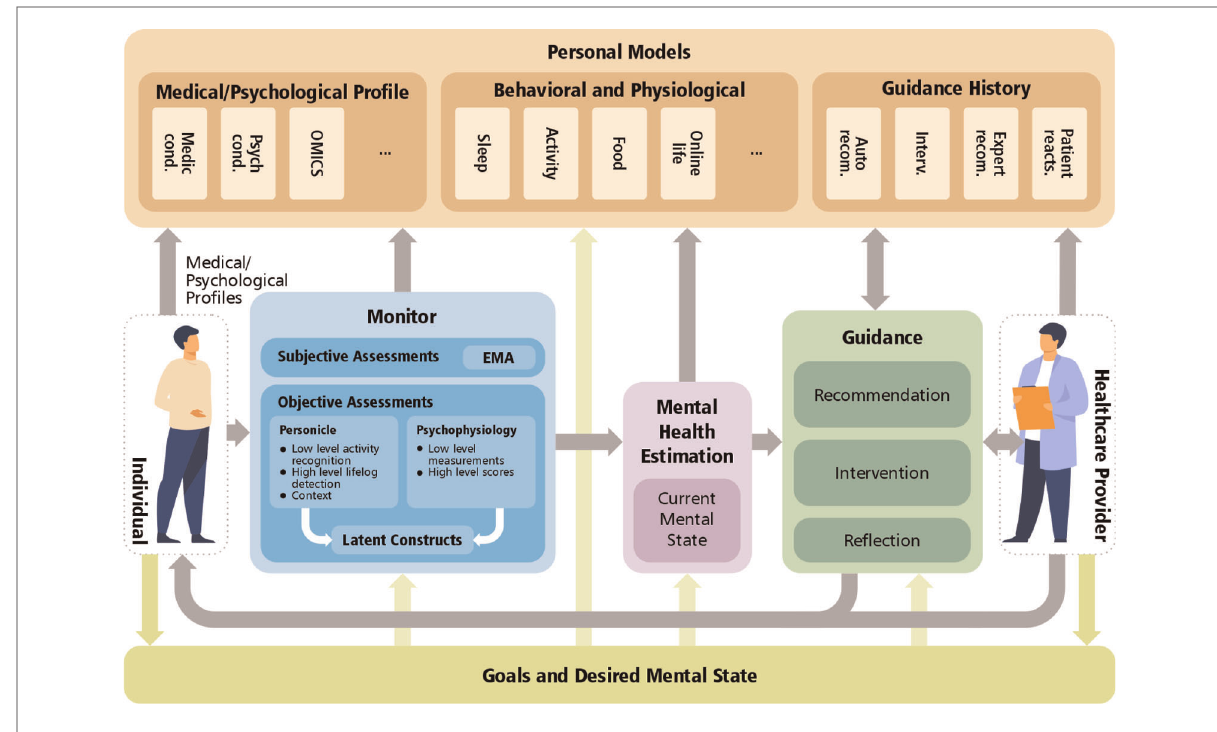
FIGURE 1 The personalized Mental Health Navigator (MHN) system enabled by a goal-based closed-loop